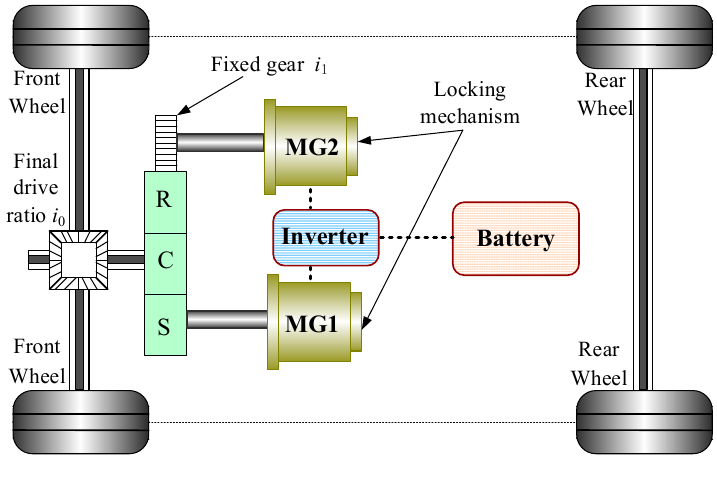
Figure 1. The configuration of dual-motor coupling. Table 2. Component working status under different working modes.